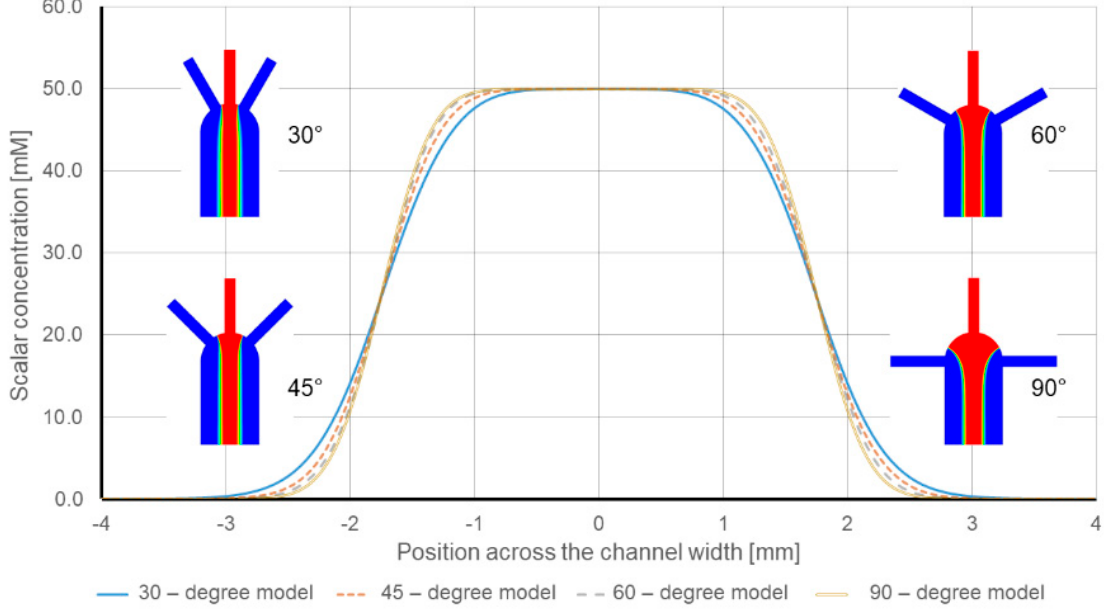
Figure 5. Numerical model results of the Species diffusion width with respect to inlets’ angle.